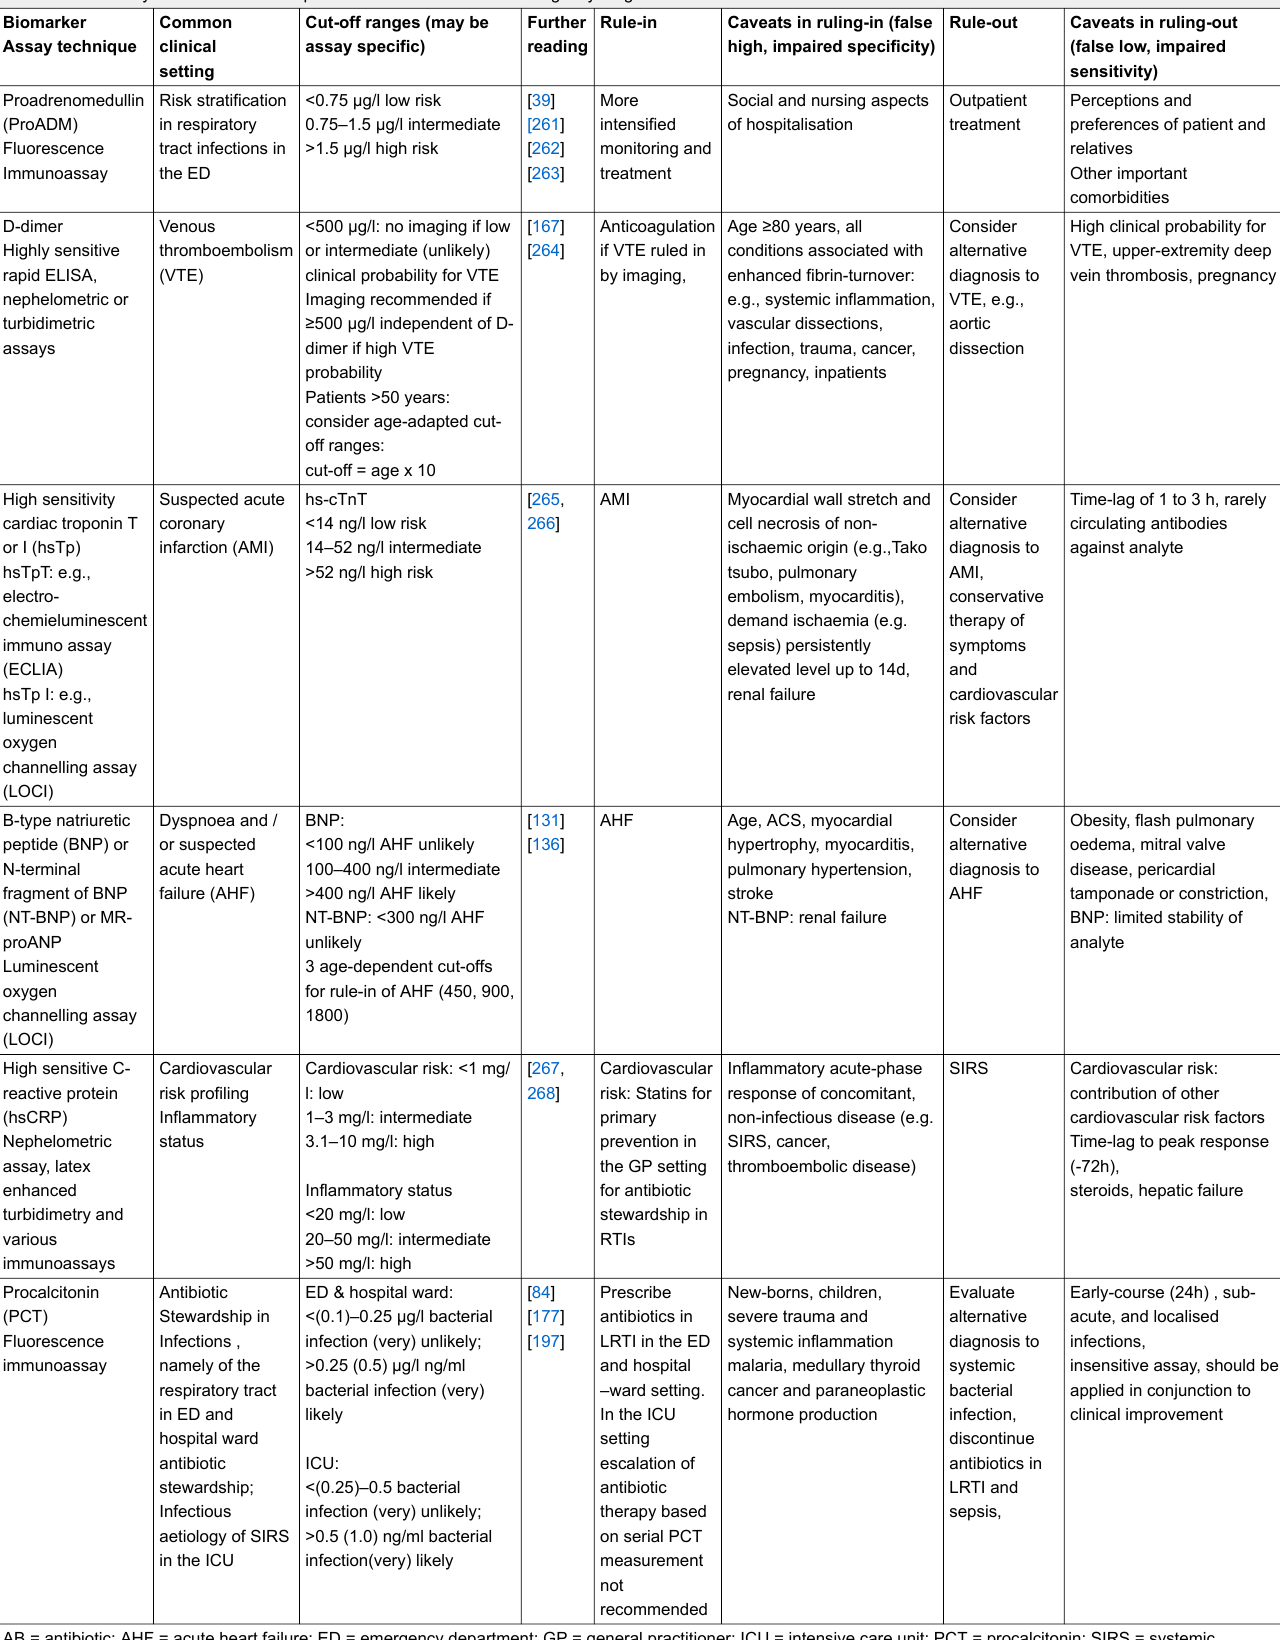
Table 1: Commonly used biomarkers to personalise medicine in the emergency triage with indications and limitations. Biomarker Common Assay technique